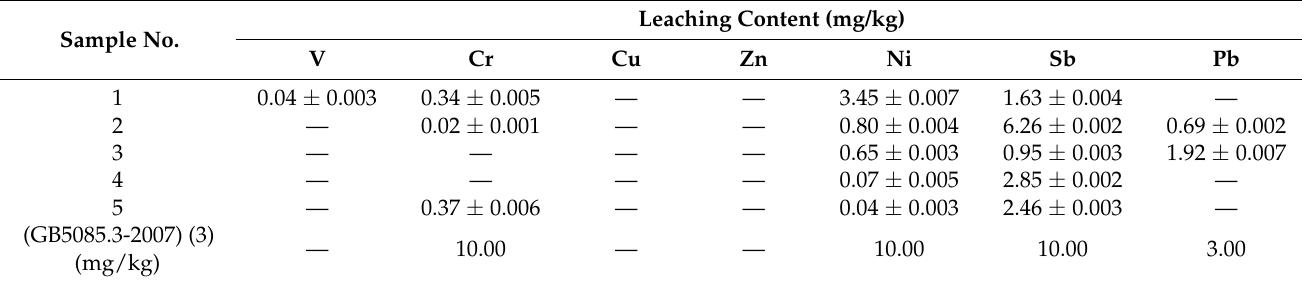
Table 5. Leaching results of heavy metals in the slag after pyrolysis (BFS-P). Sample No.